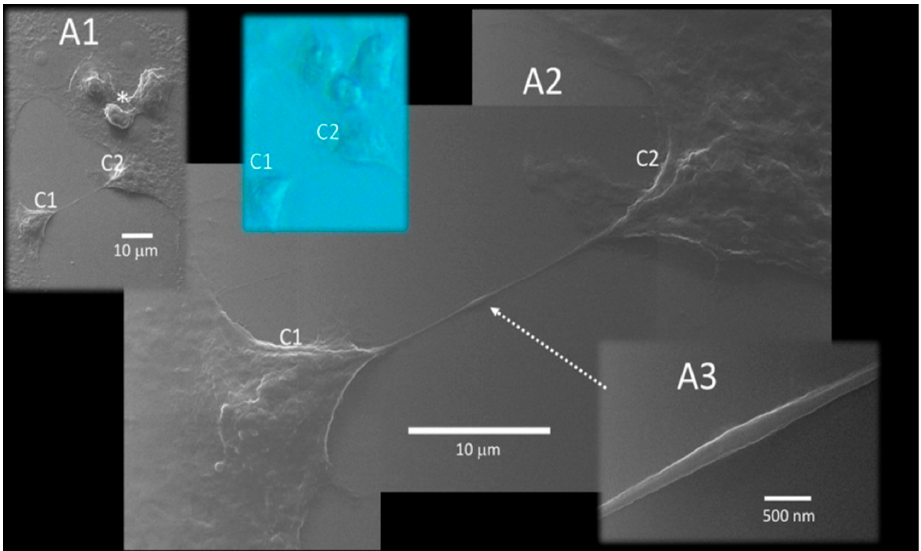
Figure 2. Tunneling nanotube (TNT), interconnecting two distant cells, C1 and C2. A trio of bulging and detaching infected cells (asterisk in A1) may be detected nearby, as well as healthy cells. Both cells are shaped with a stretched morphology by this extended TNT (A2). TNT stretched between two cells frequently bulges in the middle (dotted arrow; magnified in A3). This image is reproduced from an open-access article distributed under the terms of the Creative Commons CC BY license, which permits unrestricted use, distribution, and reproduction in any medium, provided the original work is properly cited. Source: [121].